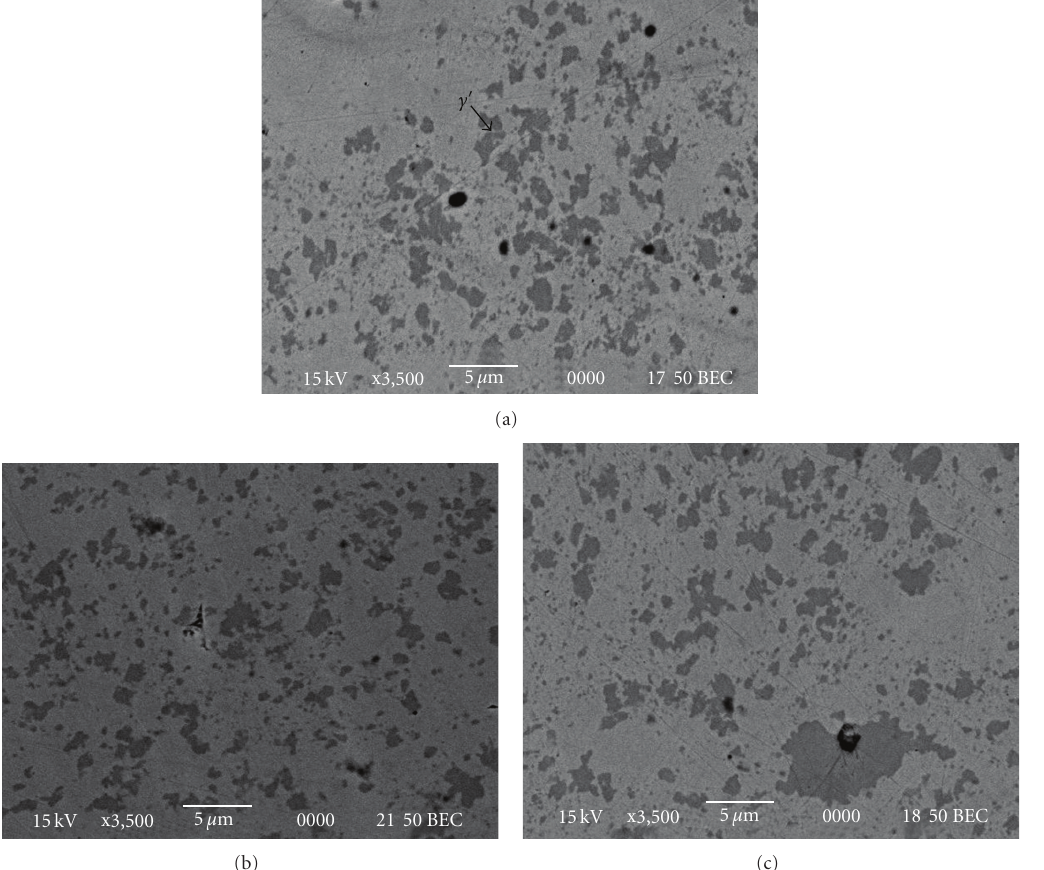
Figure 4: SEM micrographs of Ni-15at%Al (MA) after annealing at 900 ◦ C for 24h (a), 72 h (b), and 120 h